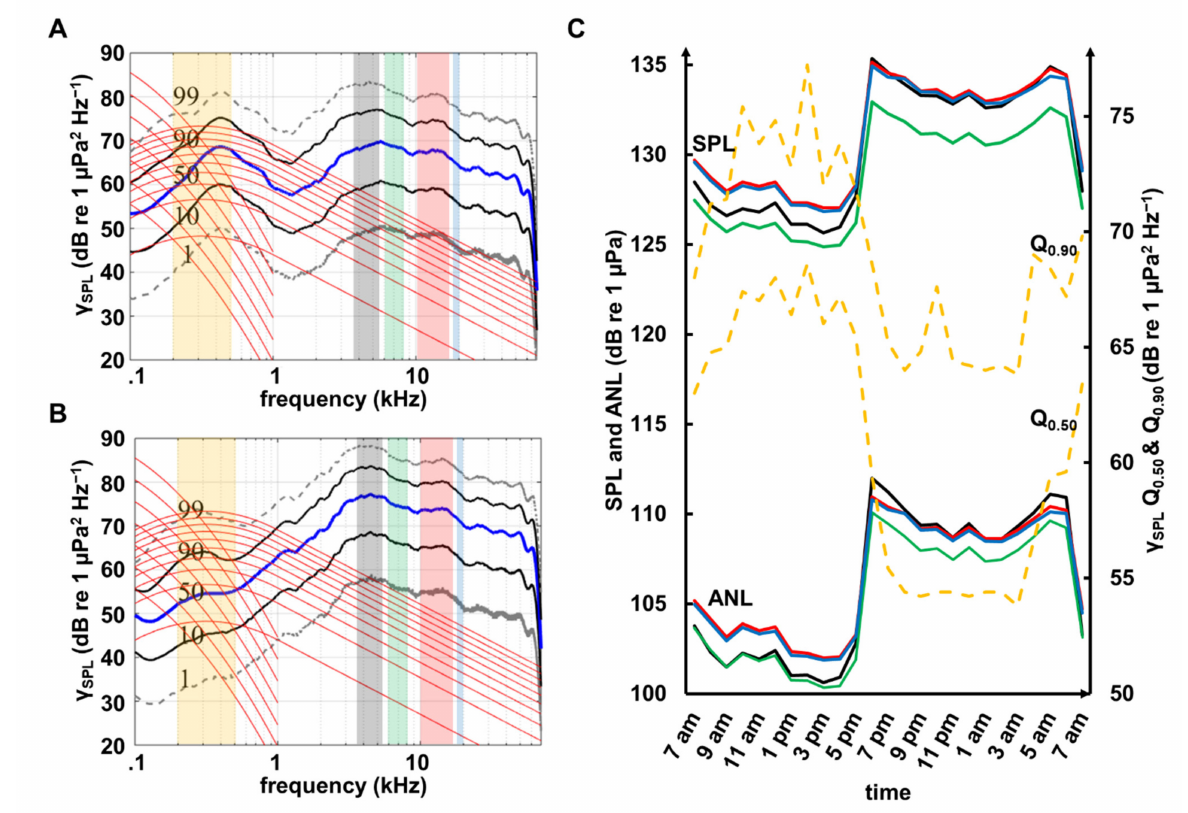
Figure 4. Power spectral density at the fixed recording station at –12 m depth and 127 m distance from the reef crest at ( A ) 2 p.m. and ( B ) midnight. In dashed grey, percentiles Q 0.01 and Q 0.99 ; in black, percentiles Q 0.10 and Q 0.90 ; in bold blue, the median Q 0.50 and in red, Wenz background noise for wind speeds between 0 and 30 kn and ship traffic index between 1 and 7. ( C ) Diel pattern of sound pressure level (SPL) and ambient noise level (ANL) (left scale) for benthic BTS bands (3.5–5.5 kHz, 6–8 kHz, 10–13 kHz and 14–17 kHz) highlighted respectively in black, green, red and blue non-dashed lines (also highlighted in the vertical rectangles in ( A , B )). Diel pattern of Q 0.50 and Q 0.90 of power spectral density ( γ SPL) (right scale) for the frequency band between 200 and 500 Hz corresponding to the daytime fish chorus highlighted in orange (dashed